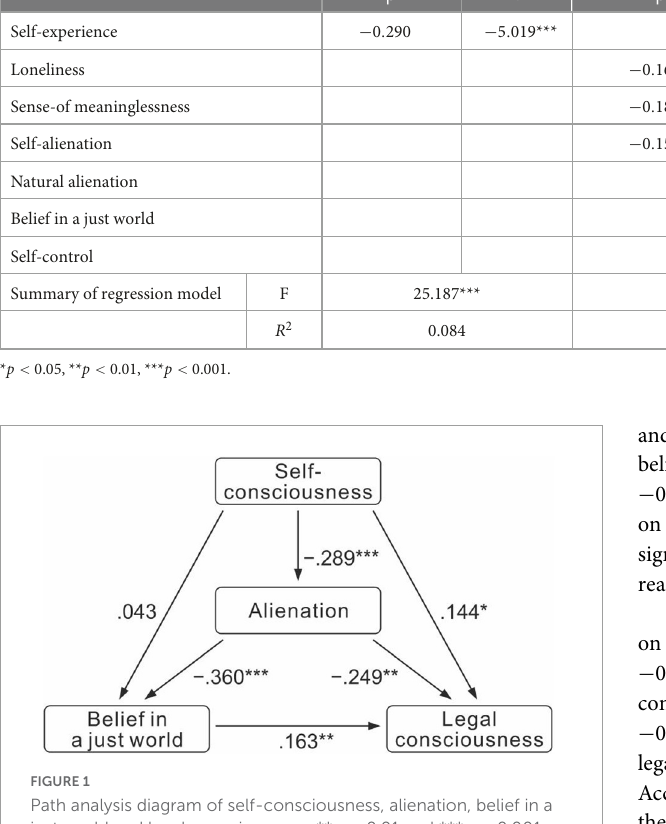
had positive influences on legal consciousness. According to the determination coefficient, four predictive variables can account for 18.8% of legal